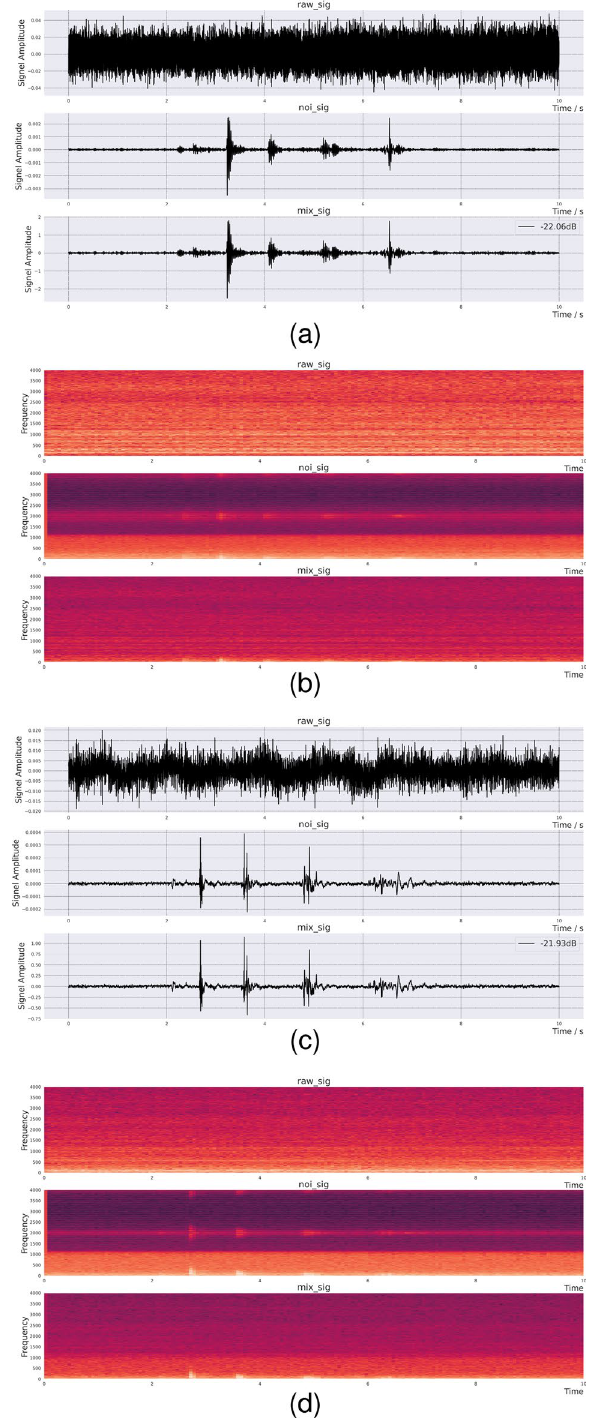
Fig. 4 Two samples of the